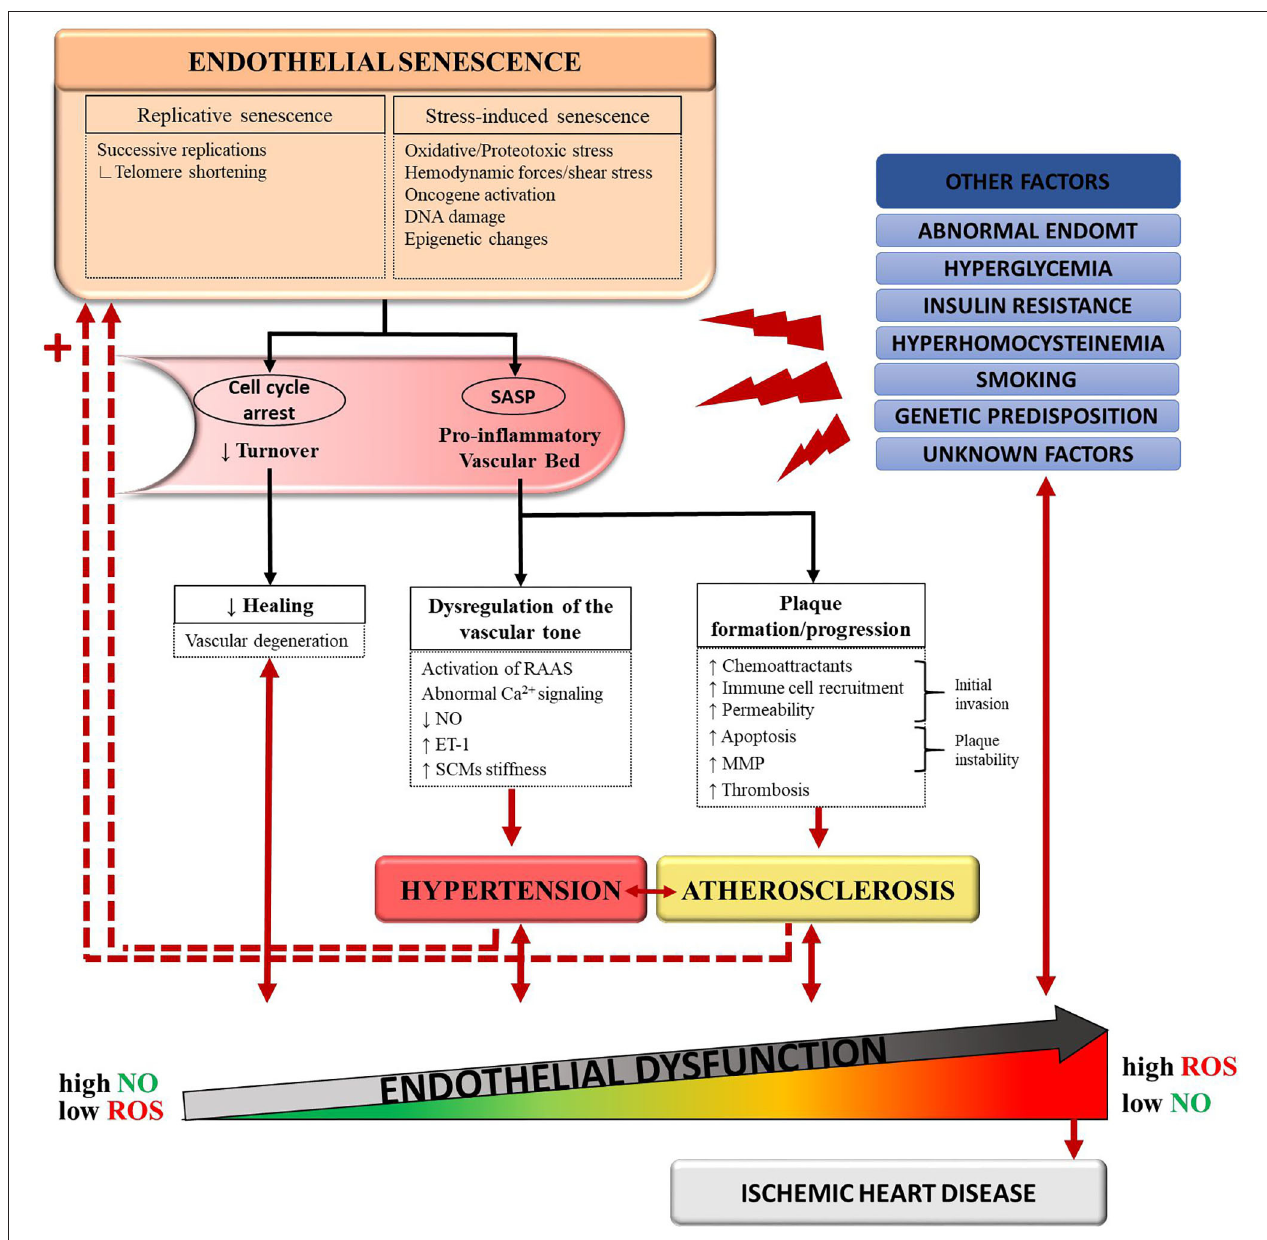
FIGURE 1 | Schematic representation of the proposed connections between senescence, hypertension, atherosclerosis, and endothelial dysfunction. Normal aging and deleterious stimuli induce senescence in endothelial cells (ECs), vascular smooth muscle cells (VSMCs), and foam cells. Accumulation of these senescent cells favors a pro-inflammatory state of the vascular bed through the senescence-associated secretory pathway (SASP). In turn, the SASP promotes pathological changes leading to the development of hypertension and atherosclerosis. In a feedback manner, hypertension and atherosclerosis induce more stressors to an already dysfunctional and senescent vessel wall. This vicious circle translates into endothelial dysfunction and, eventually, ischemic heart disease. Other causal pathways of endothelial dysfunction include hyperglycemia, insulin resistance, abnormal endothelial-to-mesenchymal transition (EndoMT), genetic predisposition and detrimental lifestyle habits such as smoking. ET-1, endothelin-1; MMP, matrix metalloproteases; NO, nitric-oxide; RAAS, renin–angiotensin–aldosterone system; ROS, reactive oxygen